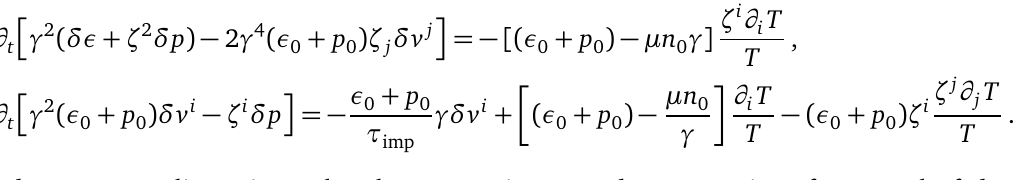
Figure 2: Polar angle dependence of the residues of σ x y for ω ω (dashed lines) in units of [ meV. τ 2 2 tween the applied electric field and the tilt vector ζ . The sign of the two residues are opposite as in (46) and